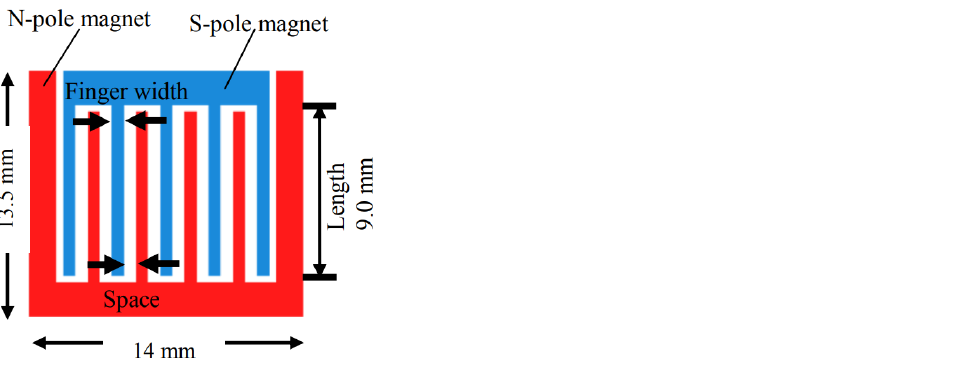
Figure 2. The proposed design for the magnet arrangement for the MEMS harvester created by [42].